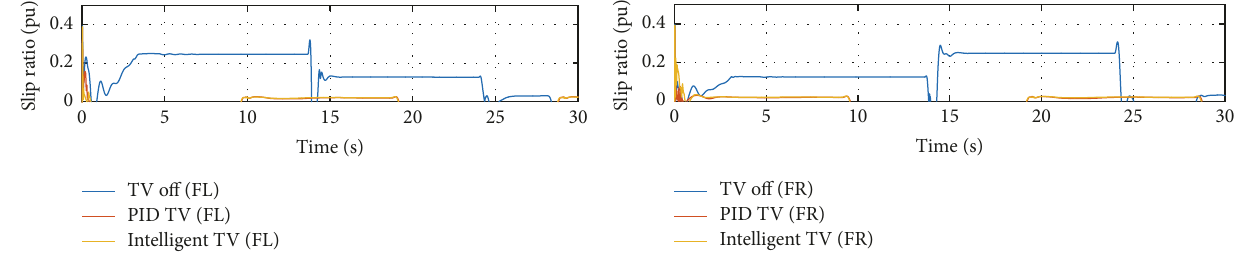
Figure 12: Wheels slip ratio.